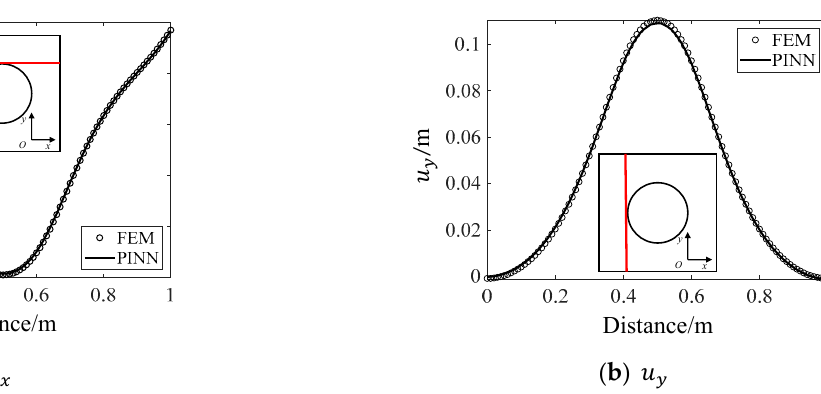
Figure 8. Comparison of the obtained displacement, represented by the red line (from left/bottom to right/top). ( a ) horizonal and ( b ) vertical displacement distributions of the marked regions.